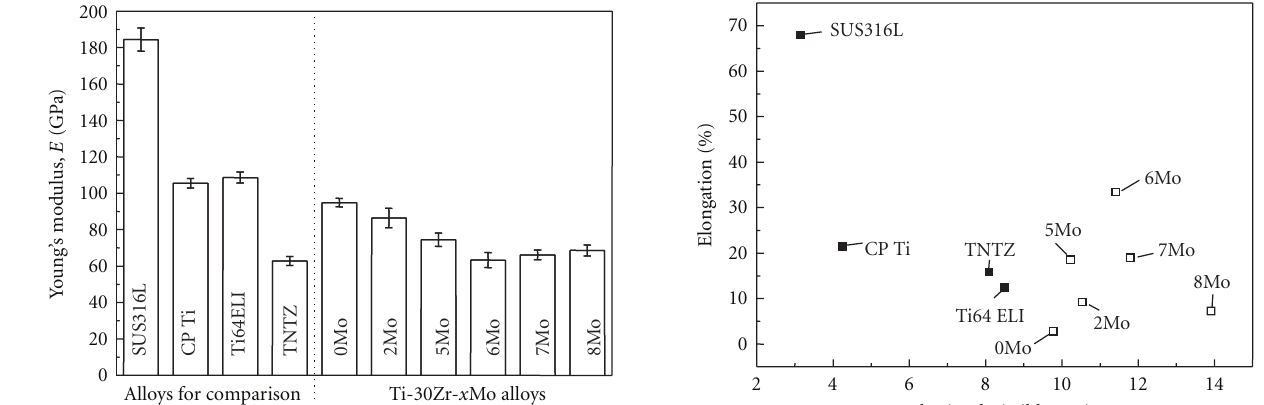
Figure 15: Distribution of solutionized Ti-30Zr- x Mo ( x = 0, 2, 5, 6, 7, and 8mass%) alloys and the alloys considered for comparison in a plot of elastic admissible strain against elongation.